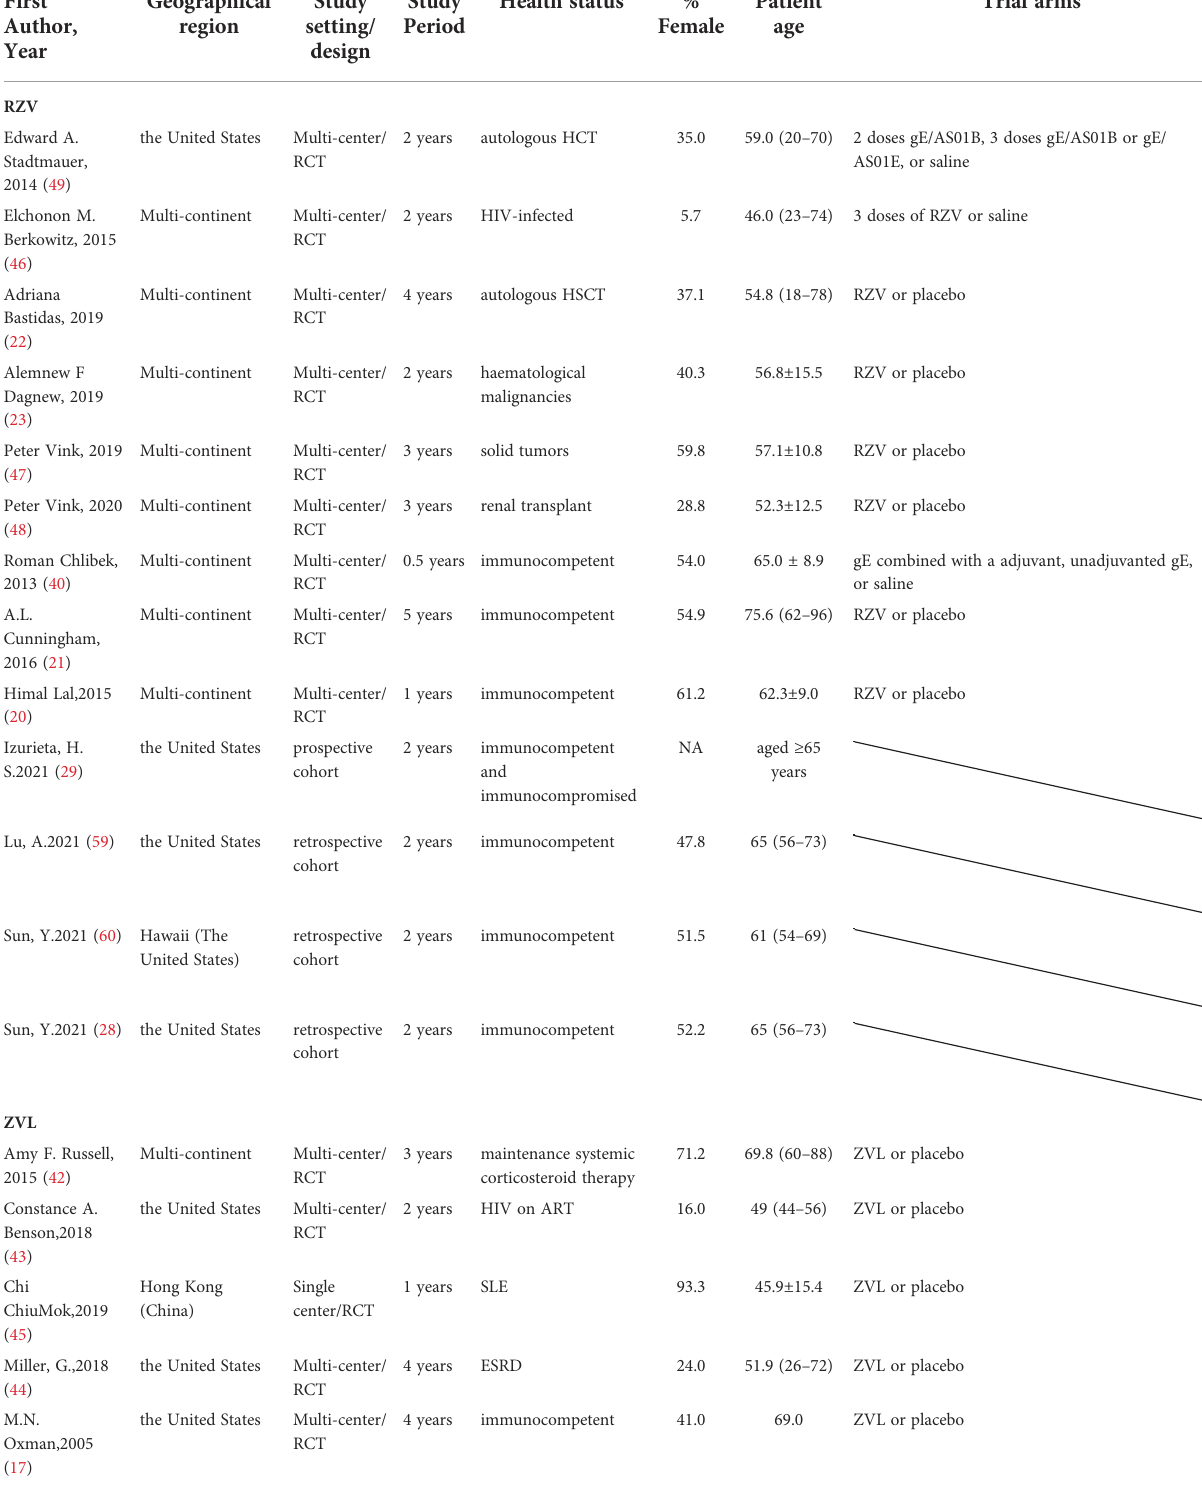
TABLE 1 Characteristics of included